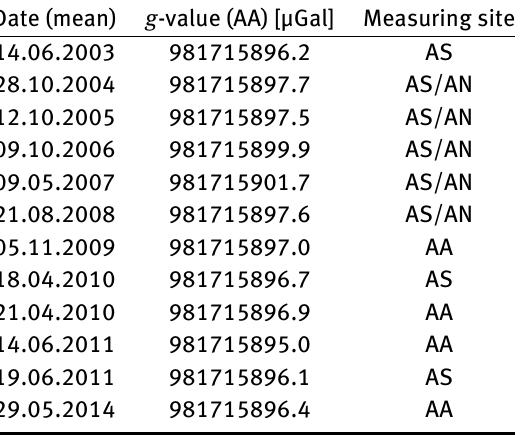
Table 1: Compilation of gravity values as measured with the FG5 gravimeter of LUH at Onsala. The results at AN and AS from the same epoch were combined by centering the AN result on AS and then calculating the artihmetric mean of the AN and AS observa- tions.The new laboratory with AA has been available since 2009 and all AS/AN results were centered on AA. In 2012, FG5-220 was upgraded to FG5X-220. The applied reductions for non-tectonic vari- ations were derived from the recordings with the superconducting gravimeter GWR#54 (since 2009). The reference height above floor level at AA is 1.200